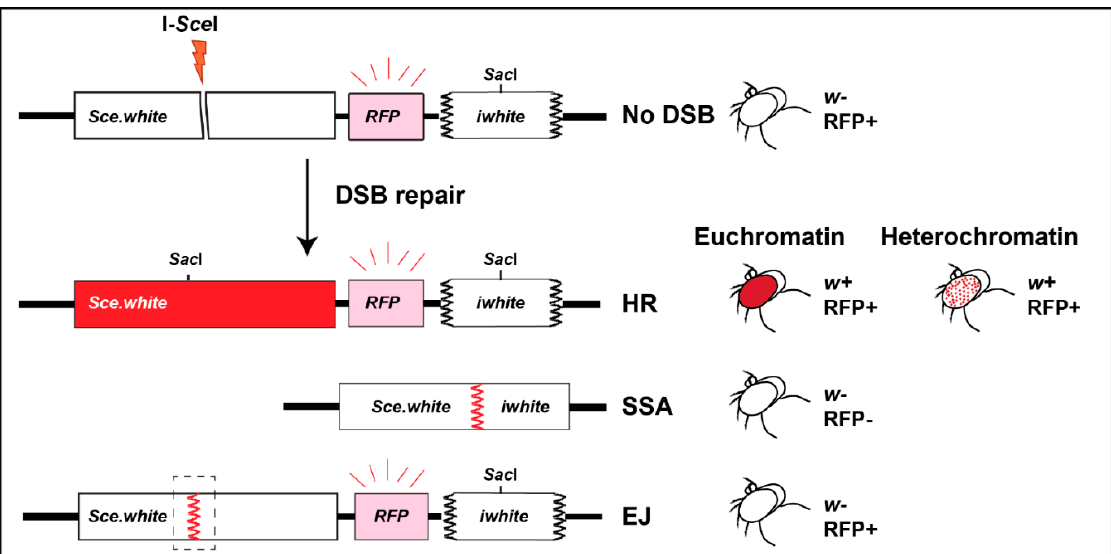
Figure 5. Schematic representation of DR-white cassette and repair outcomes. The DR- white reporter is composed of an upstream nonfunctional white gene ( Sce.white ) containing an I- Sce I target sequence, a red fluorescent marker (RFP), and a downstream truncated nonfunctional white gene ( iwhite ) (Adapted from [75]). Sce.white contains a premature stop codon as part of the I- Sce I recognition sequence. Repair of DSBs induced by I- Sce I in the germline of male flies can be detected in the progeny. HR repair of euchromatic insertions results in red eyes, and HR of heterochromatic insertions results in variegated-red eyes [33]. SSA results in white- , RFP- flies. Uncut, NHEJ, or Alt-EJ result in white- , RFP+ progeny, and different repair products can be distinguished by sequencing across the cut site.